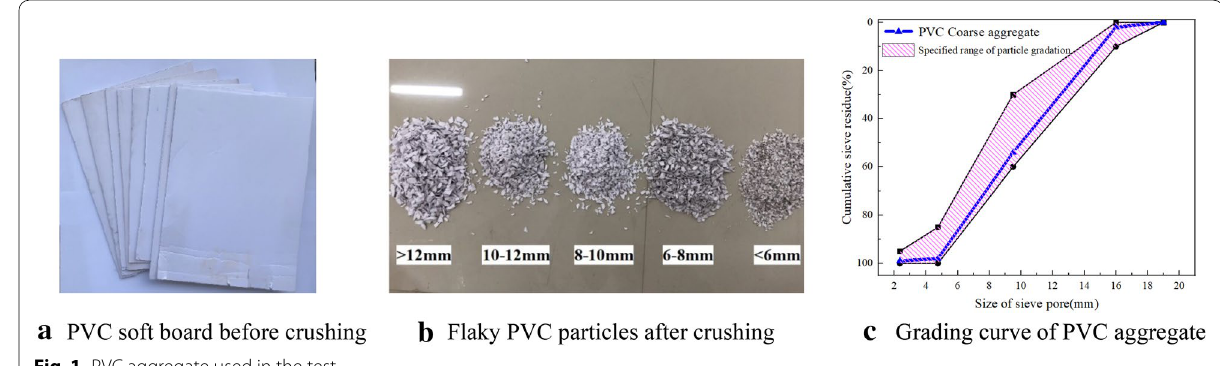
Fig. 1 PVC aggregate used in the